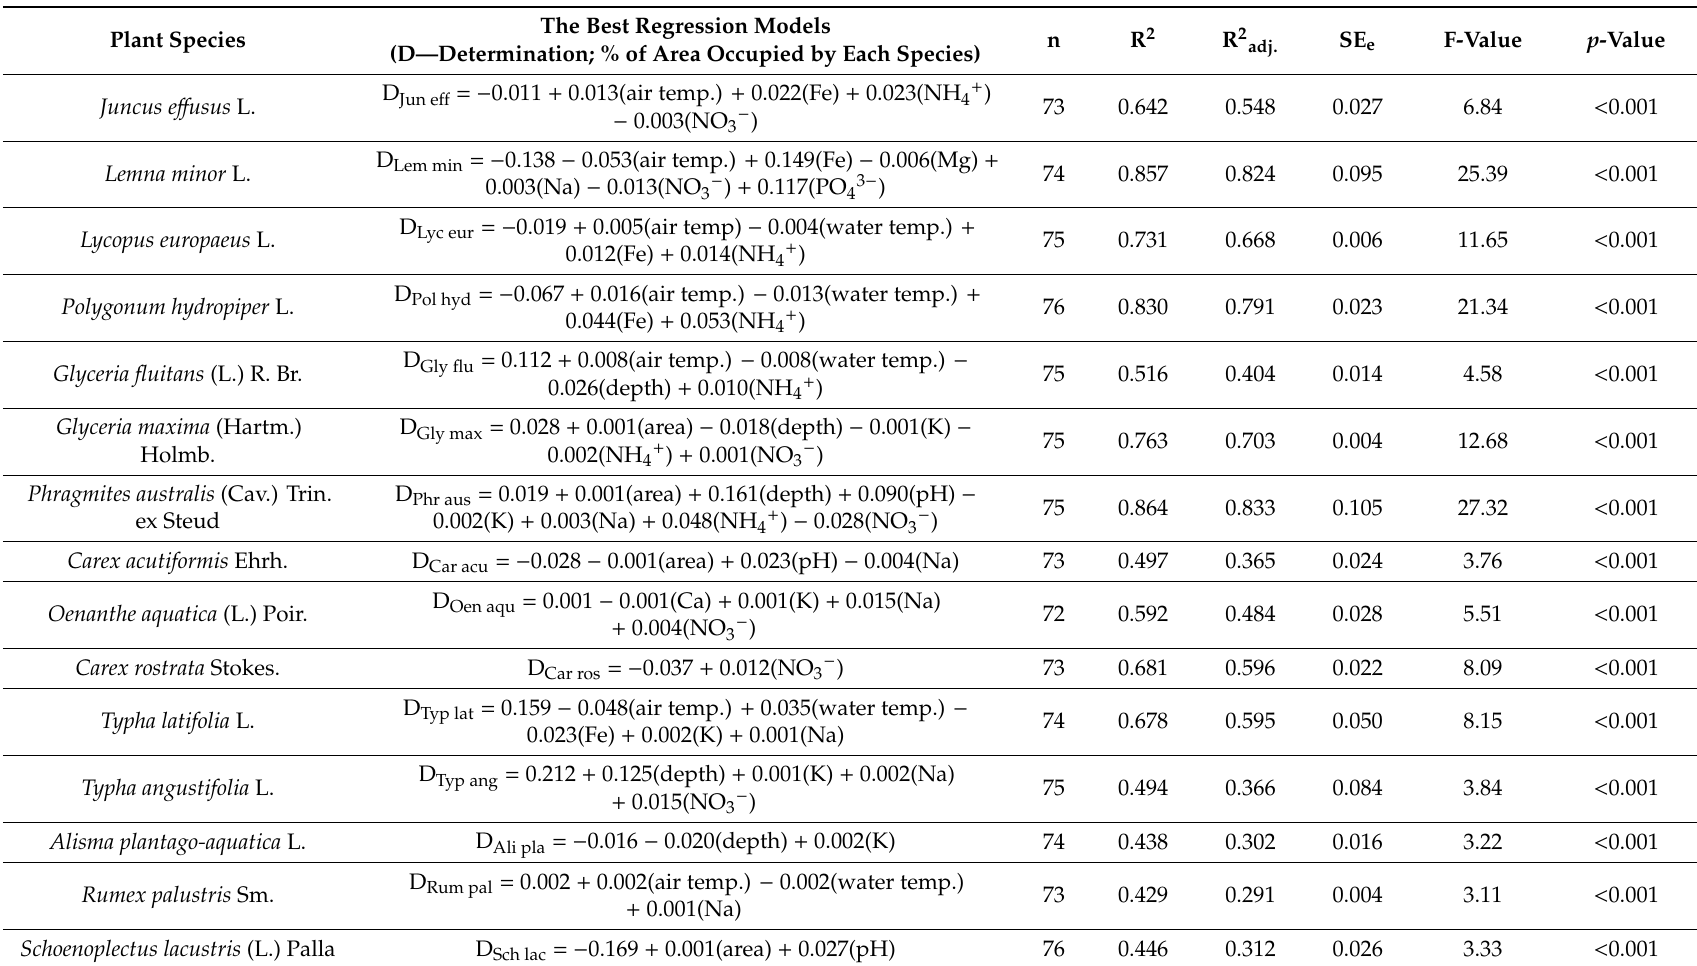
Table 7. The best regression model for plant